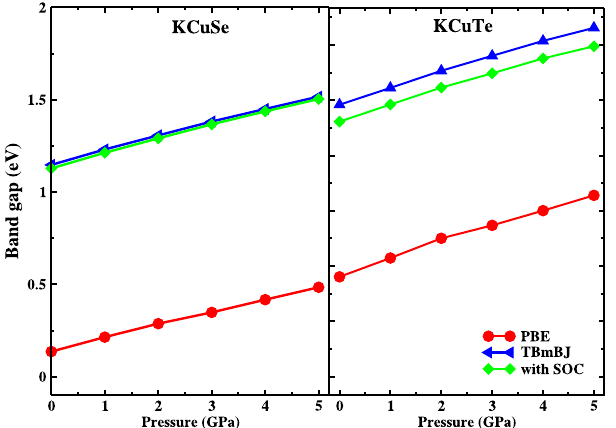
Figure 5. Effect of pressure (0–5 GPa) on band gaps using PBE, TBmBJ potentials and by incorporating SOC. The band gaps remain direct (at Γ ) under the influence of